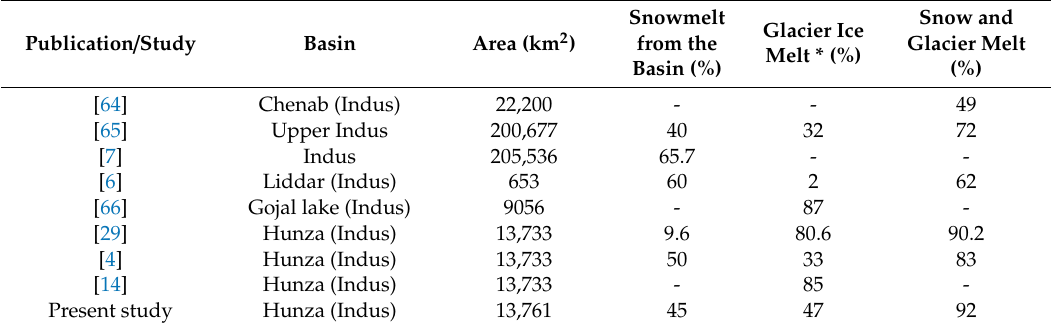
Table 7. Values of snow and glacier melt contribution to total river discharge according to various studies in areas in or near to the Hunza